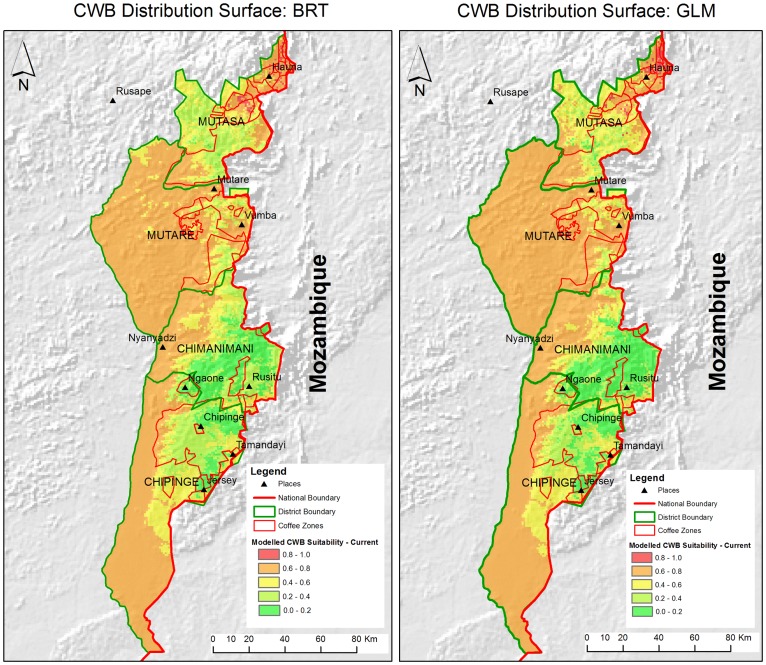
Probability of occurrence of CWB that determines its distribution surface in the four Districts.
Figure 2(a) shows the probability of CWB occurrence for each area obtained from BRT model. Figure 2(b) shows the probability of CWB occurrence for each area obtained from GLM.